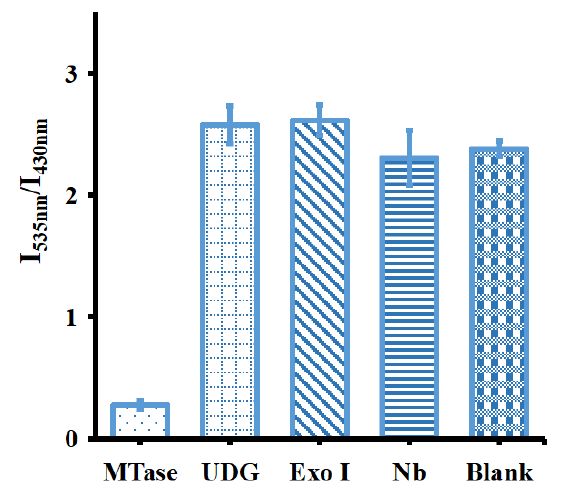
Figure 4. Fluorescence ratios of the biosensor in presence of UDG, Exo I, and Nb.BTSI. Error bars were estimated from three replicate measurements.